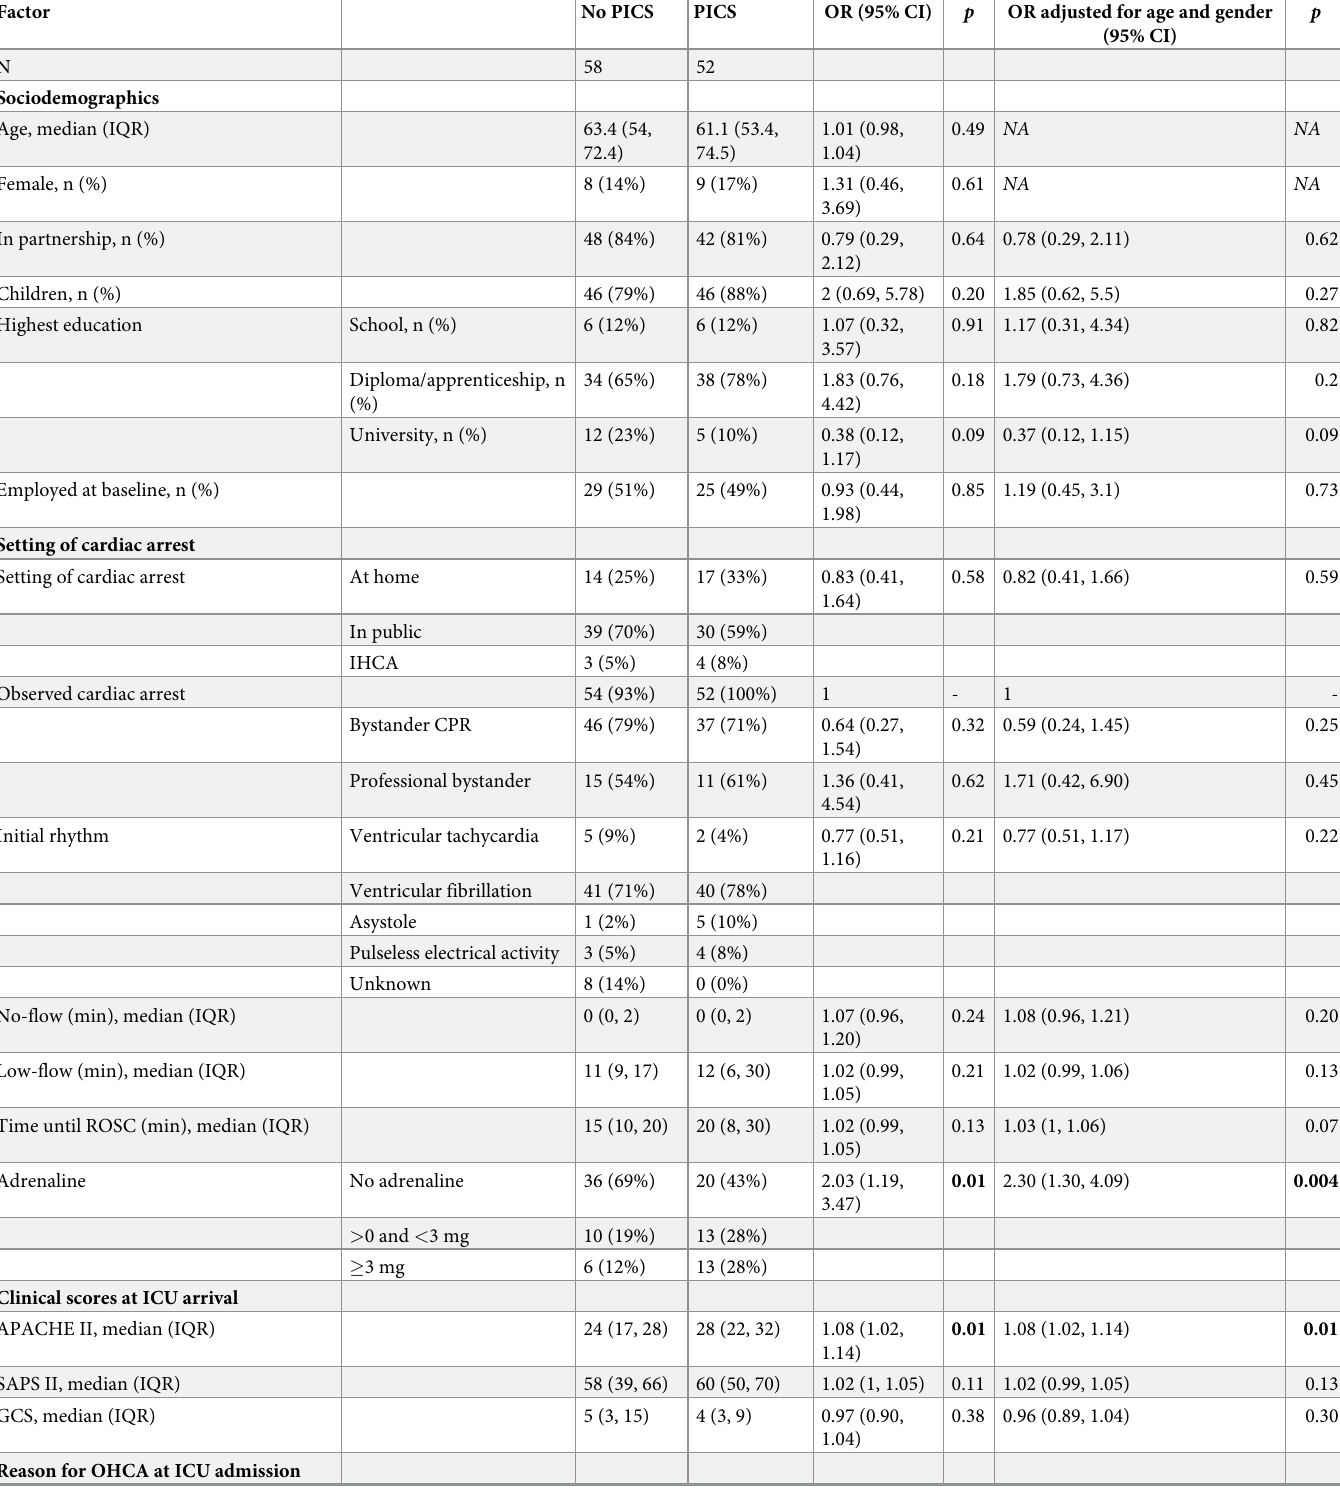
Table 3. Associations of predictor variables and post-intensive care syndrome at 12